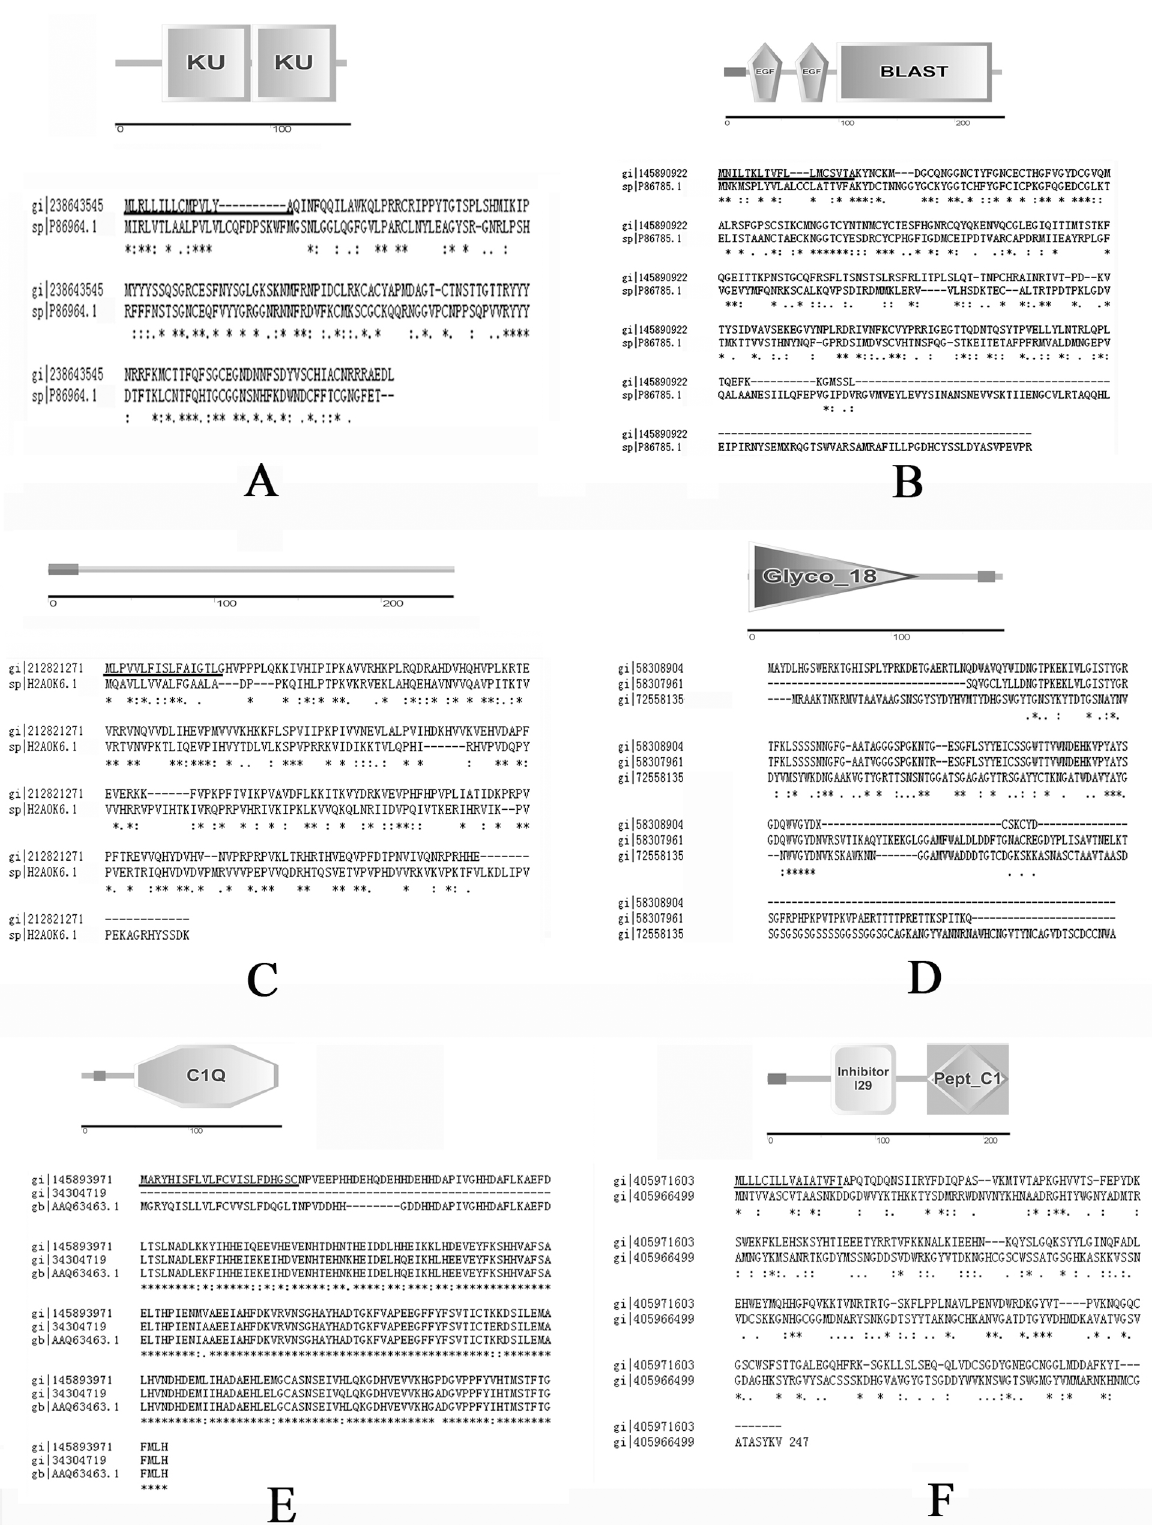
Fig 5. Domain organization and sequence alignment of representative novel proteins of M . galloprovincialis shell with their homologous from other shell. A: protease inhibitor-like protein of M . galloprovincialis (gi|238643545) and NSPI2 of P . maxima (sp|P86964.1); B: EGF-domain containing